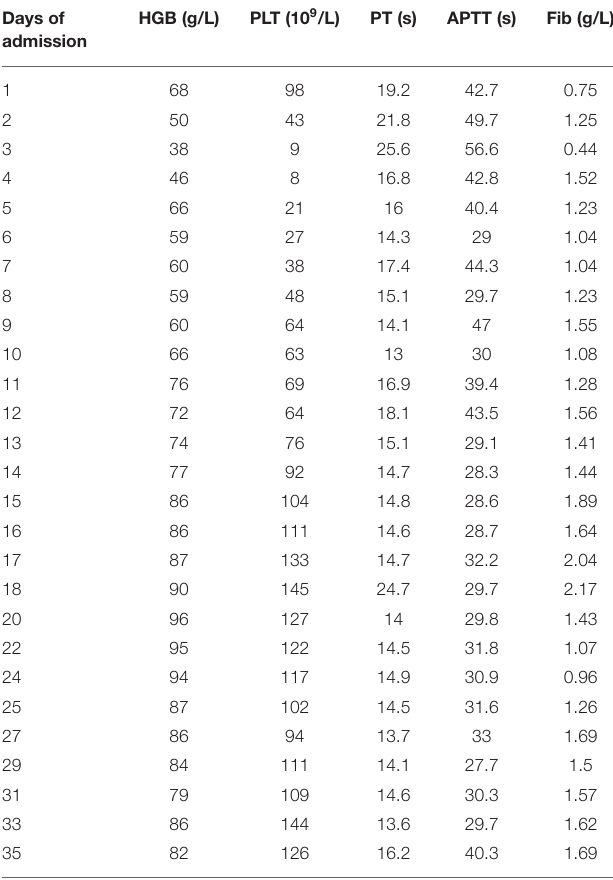
TABLE 1 | The characters of laboratory test data. Days of